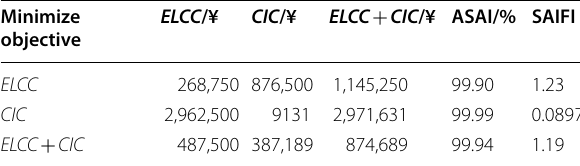
Table 3 Comparison of results under different objectives Minimize objective